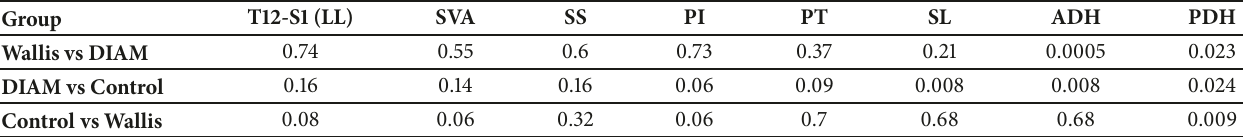
Table 2: Baseline radiographic parameters comparison (P-values, unpaired t-test).